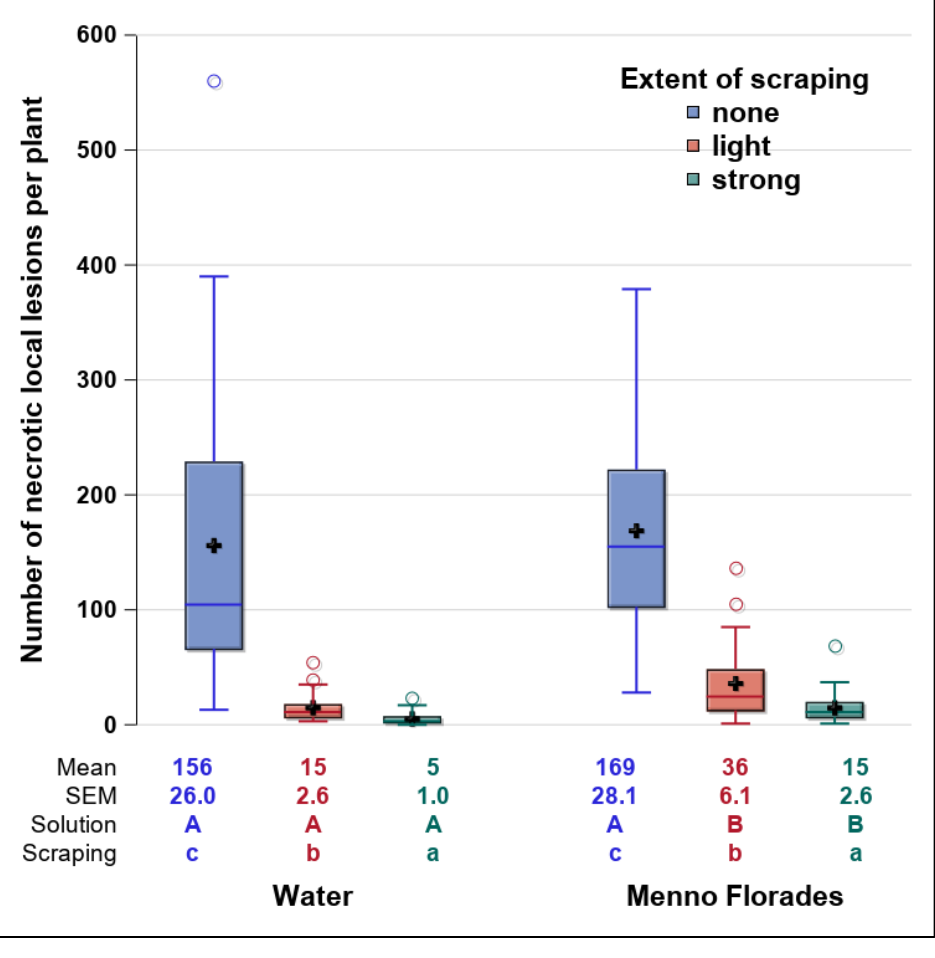
Figure 4. Efficacy of a disinfecting mat (Flexxomat PT, Royal Brinkmann, Gravenzande, The Netherlands) in combination with deionized water and Menno Florades (4%, Menno-Chemie Vertriebs mbH, Norderstedt, Germany) to Tomato brown rugose fruit virus (ToBRFV) contaminated natural rubber carriers depending on the extent of scraping shoes on the mat. After walking over the disinfection mat and scaping the shoe in a standardized manner, the carriers attached to it were immediately inoculated mechanically on susceptible N. tabacum cv. Xanthi NN to proof remaining infectiosity of the virus by counting necrotic local lesions on individual test plants. Observations are shown in a boxplot, cross inside = mean value. ‘SEM’ = Standard Error of the Mean. Letters (uppercase letters for the comparisons of solution within scraping levels, lowercase letters for the comparisons of scraping levels within solution) based on pairwise treatment comparisons using a generalized linear mixed model analysis of count data (alpha = 0.05, with Bonferroni correction). n = 24. The phenomenon—a physical depletion and no virucidal effect—was to be expected, as the contact time with the disinfectant was very short. Simply stepping on the disinfec- tion mat led to a significant reduction. A large part of the dust could already be removed in this way. If the shoes were extensively scraped on the mat, the virus concentration on